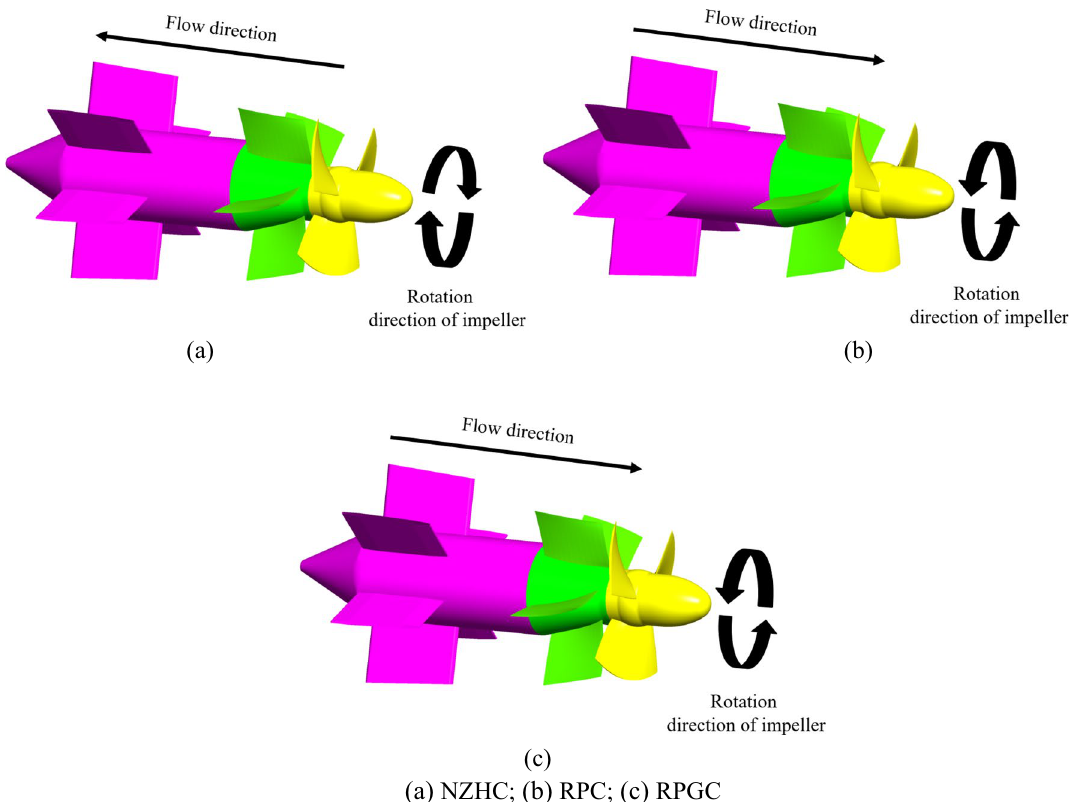
Figure 3. Rotation direction of the impeller under three special utilization conditions.